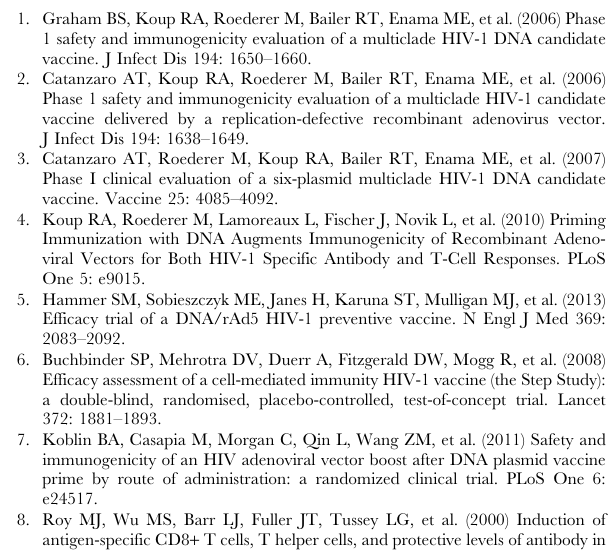
ELISA Results *Western Blot